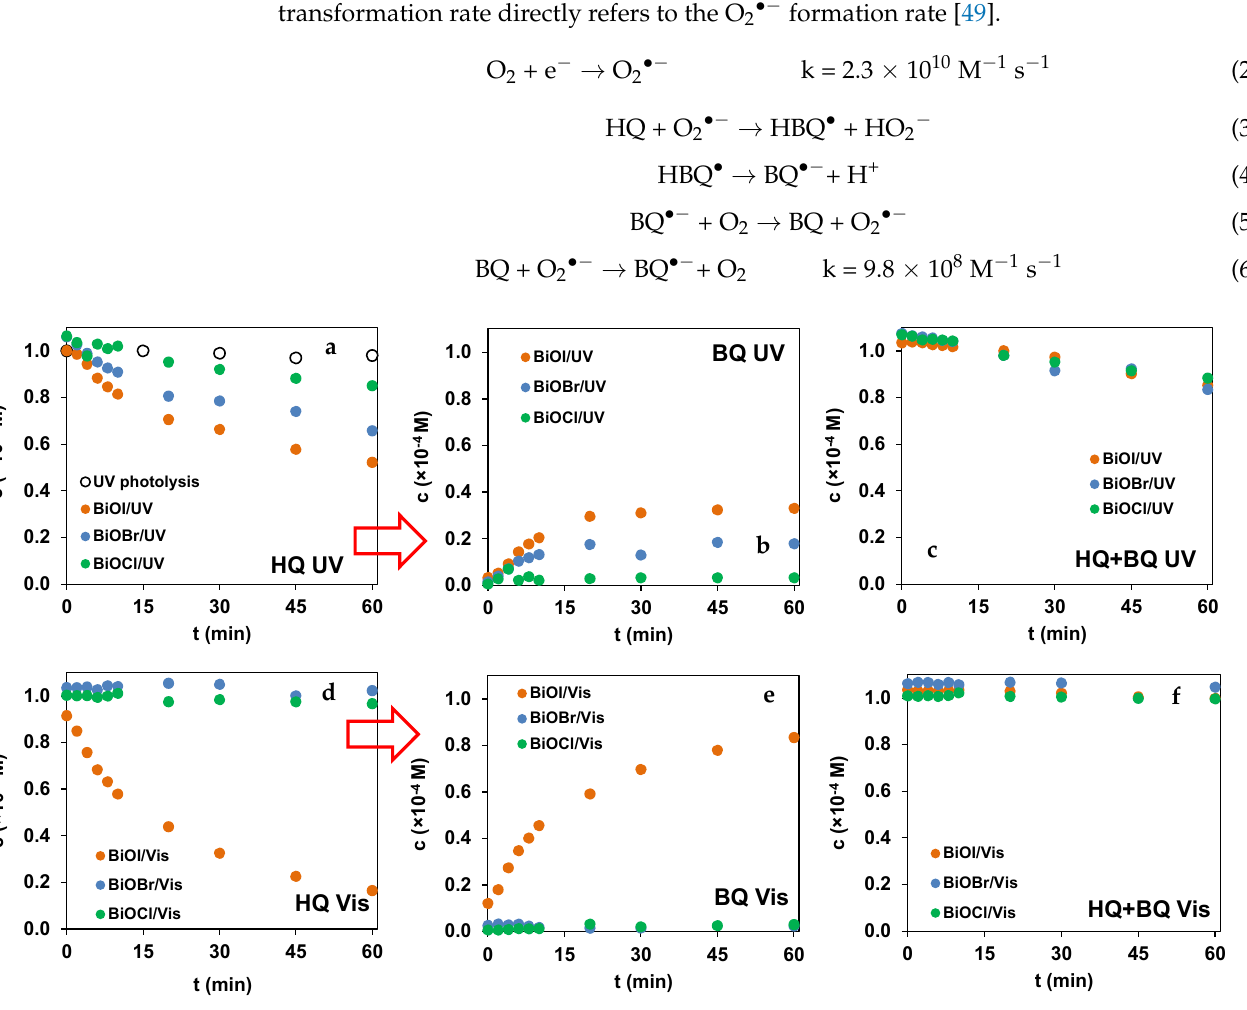
Figure 3. Transformation of HQ ( a , d ) and formation of BQ ( b , e ) and the sum of the HQ and BQ concentration ( c , f ) in aerated BiOX suspensions under UV ( a – c ) and Vis ( d – f ) radiation.